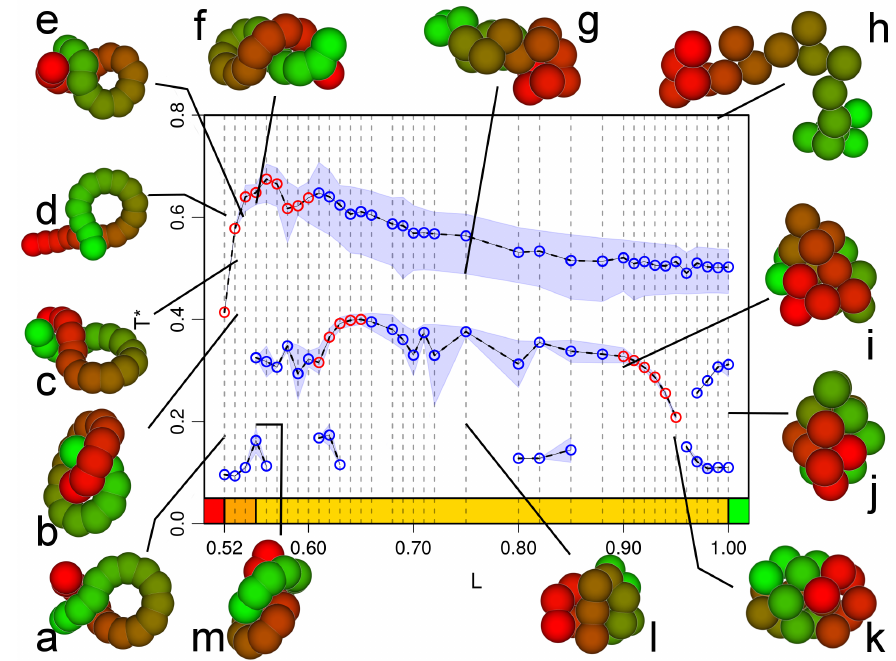
Figure 5. Pseudo phase diagram for chain length N = 20. Blue symbols indicate second order transitions, red symbols indicate first order ones. The shaded areas are error estimates based on the different quantities analyzed. Isolated points are included when they occur in more than one observable and again error estimates are given. The configurations ( a ) to ( m ) indicate most probable configurations at a given bond length and temperature